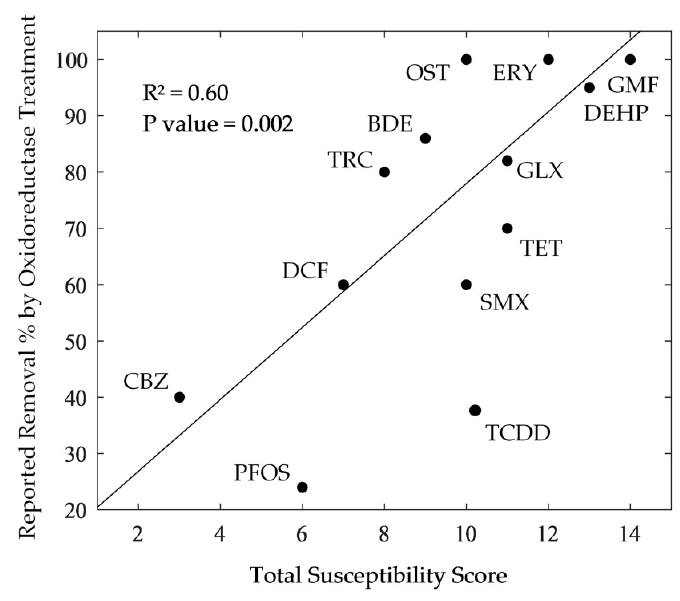
Figure 2. Correlation between total OC susceptibility scores and reported oxidoreductase treatment strategy removal rates (abbreviations were defined in Table 1).